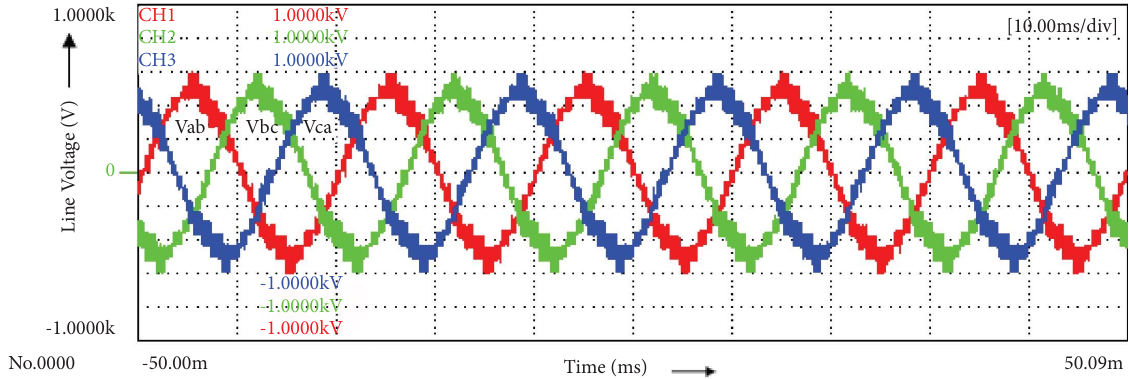
Figure 26: Line voltage waveform.